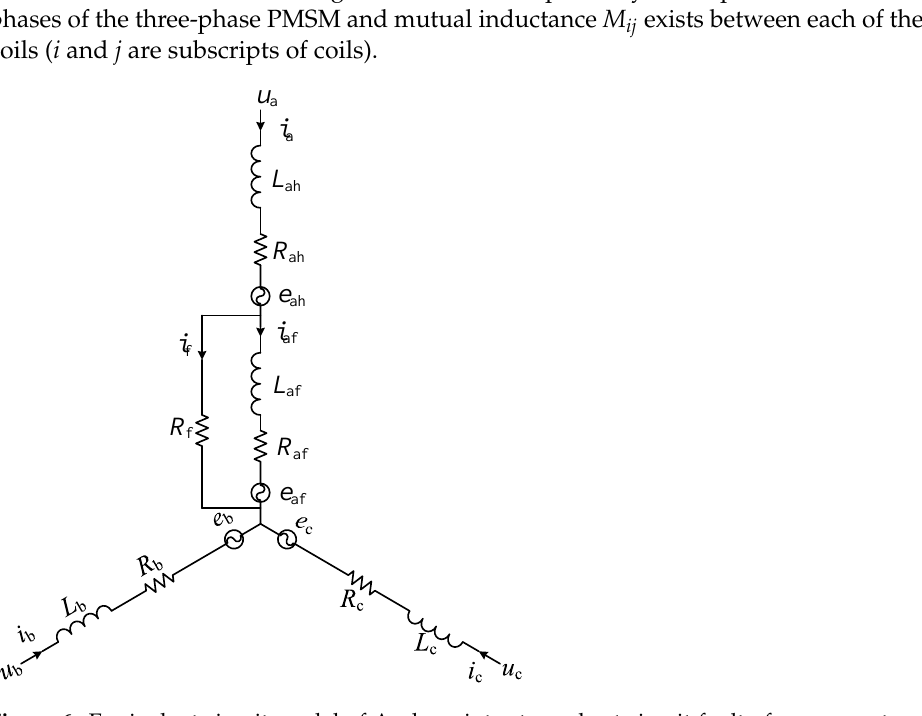
Figure 6. Equivalent circuit model of A-phase inter-turn short circuit fault of permanent magnet synchronous motor.